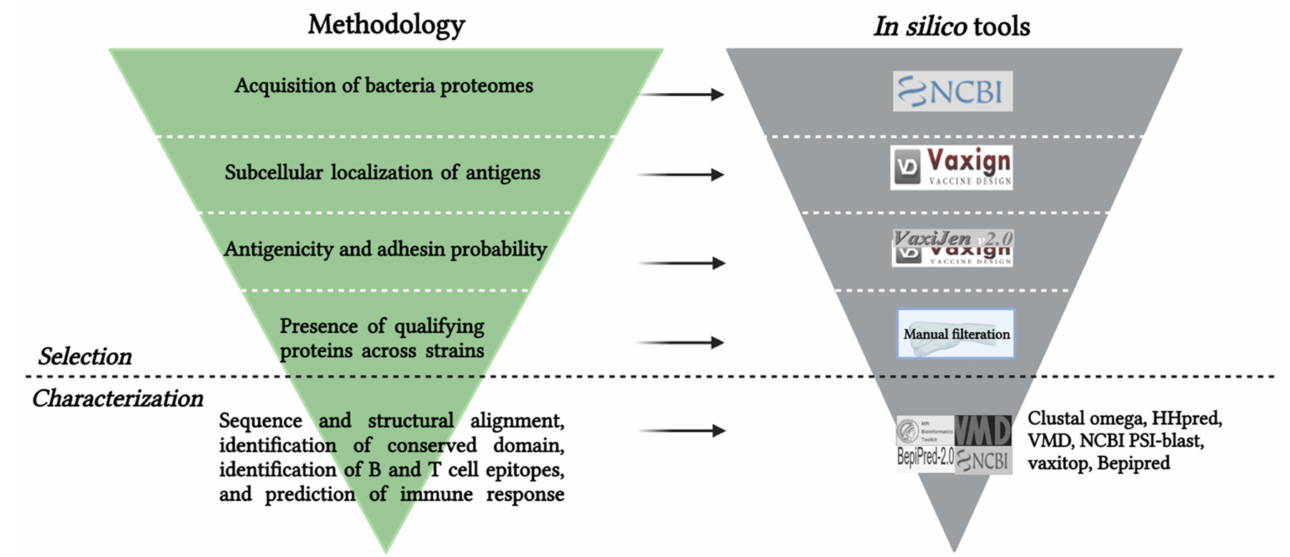
Figure 1. Pipeline used for this study to identify immunogenic proteins and epitopes of marine bacterial